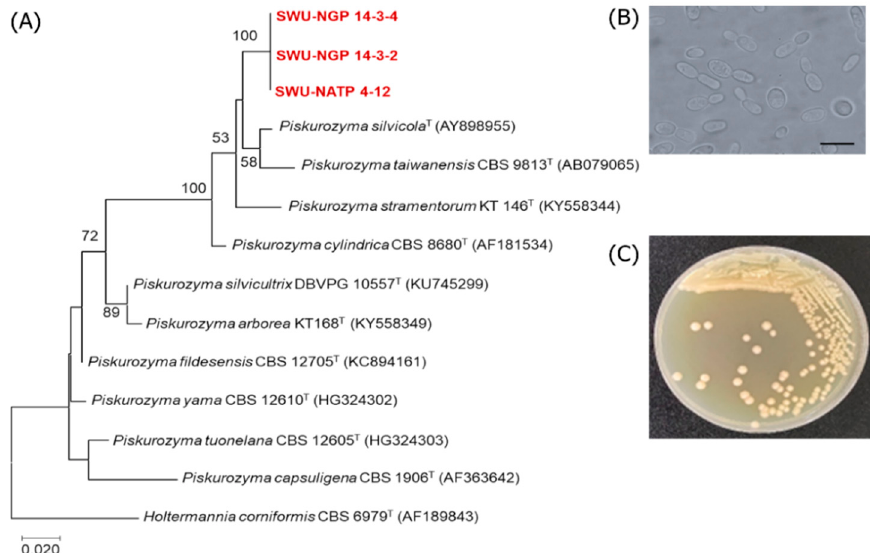
Figure 2. Phylogenetic tree ( A ) showing the positions of the strains SWU-NGP 14-3-2, SWU-NGP 14-3-4, SWU-NGTP 4-12, and their related species constructed by the maximum-likelihood method based on the D1/D2 of the LSU rRNA gene sequences. Holtermannia corniformis CBS 6979 T was used as an outgroup. The numerals represent the percentages from 1000 replicate bootstrap resampling (a frequency of less than 50% is not shown). The cells ( B ) and colony ( C ) morphology of SWU-YGP 11-1 grown on YM agar for 48 h. The bar represents as 10 µ